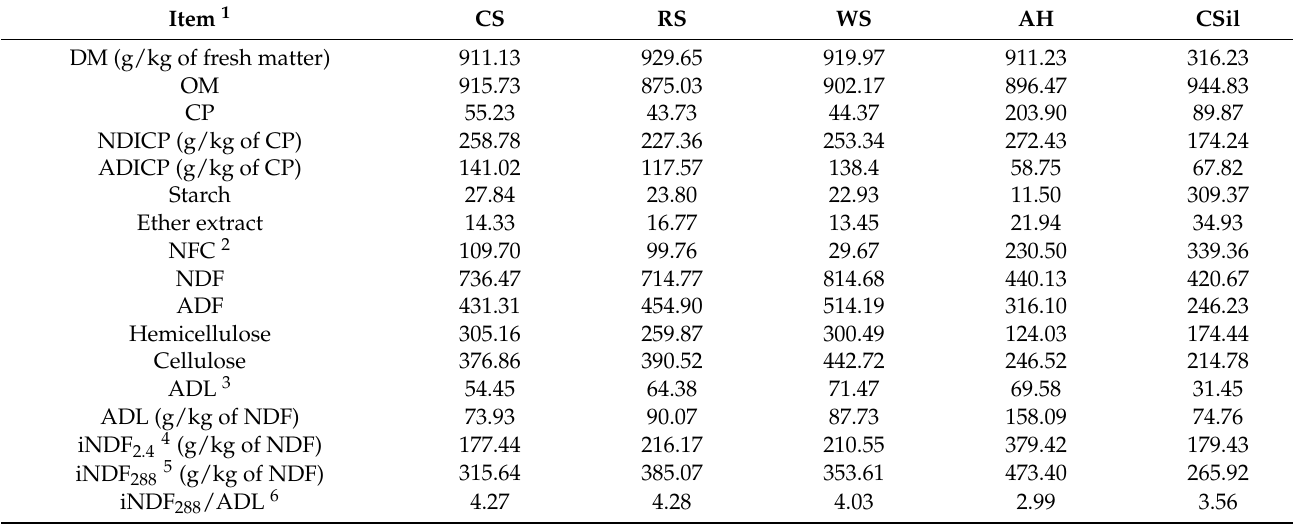
Table 1. Chemical composition and indigestible NDF of the forage samples (g/kg of DM, unless otherwise indicated). Item